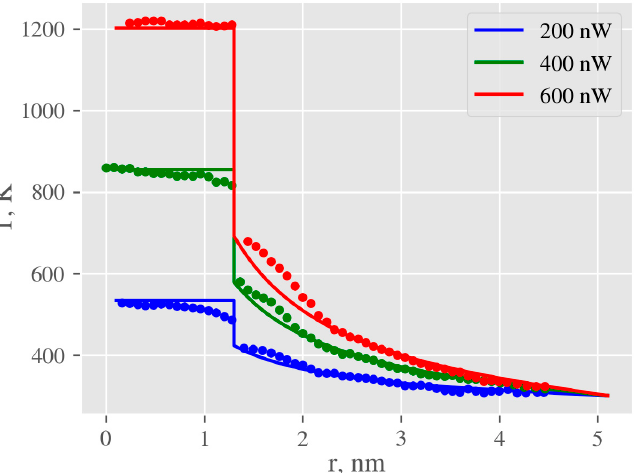
Figure 12. Comparison of temperature profiles in the AuNP-octane system obtained by continuum model (solid lines) with those calculated by molecular dynamics (dots), using finite element method (FEM). Calculations were done for total absorbed energies 200, 400, and 600 nW. Data for calculation were taken from [55].